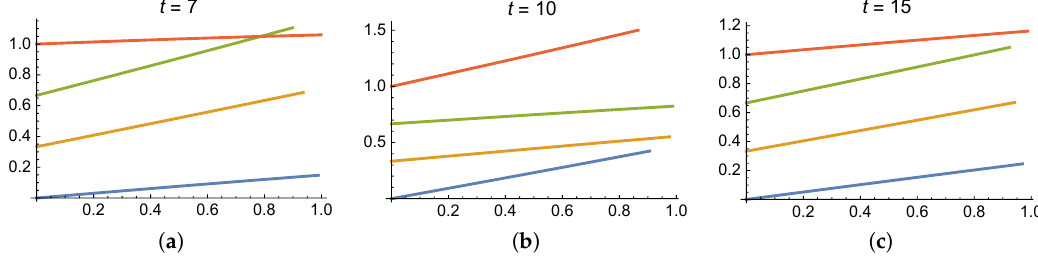
Figure 6. Three snapshots of the configuration of the array of four coupled filaments with rotation coupling. Time ( a ) t = 7s; ( b ) t = 10s; and ( c ) t = 15s.